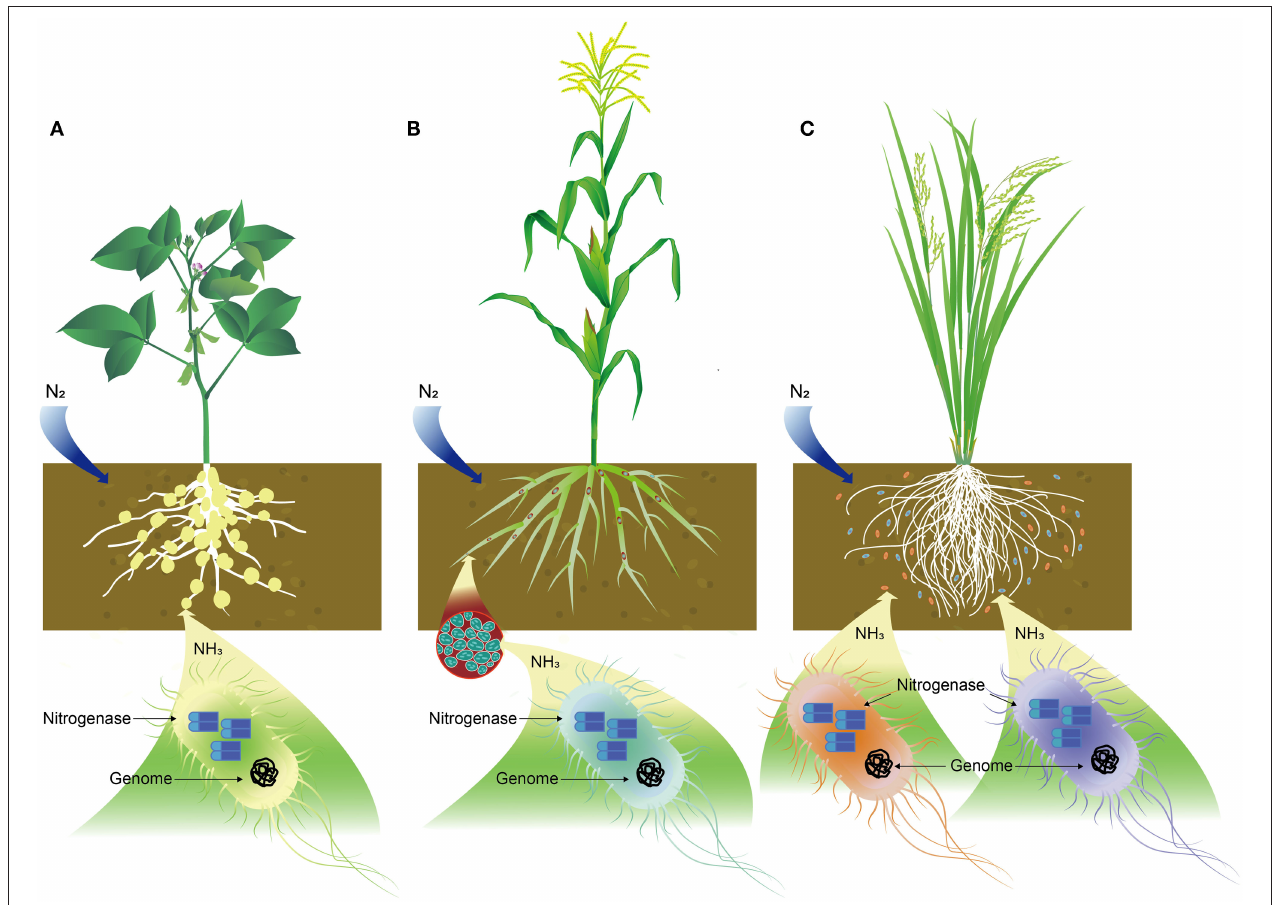
FIGURE 1 | Schematic illustration of nitrogen (N) fixation in bacteria. (A) Symbiotic relationship of Rhizobium with soybean in N fixation, (B) endophytic bacteria, like Azospirillum lipoferum in corn plant root for N fixation, and (C) N-fixing bacteria, such as Azotobacter and Azospirillum associated with rice plant roots where cobalt or cobalamin plays important role in N